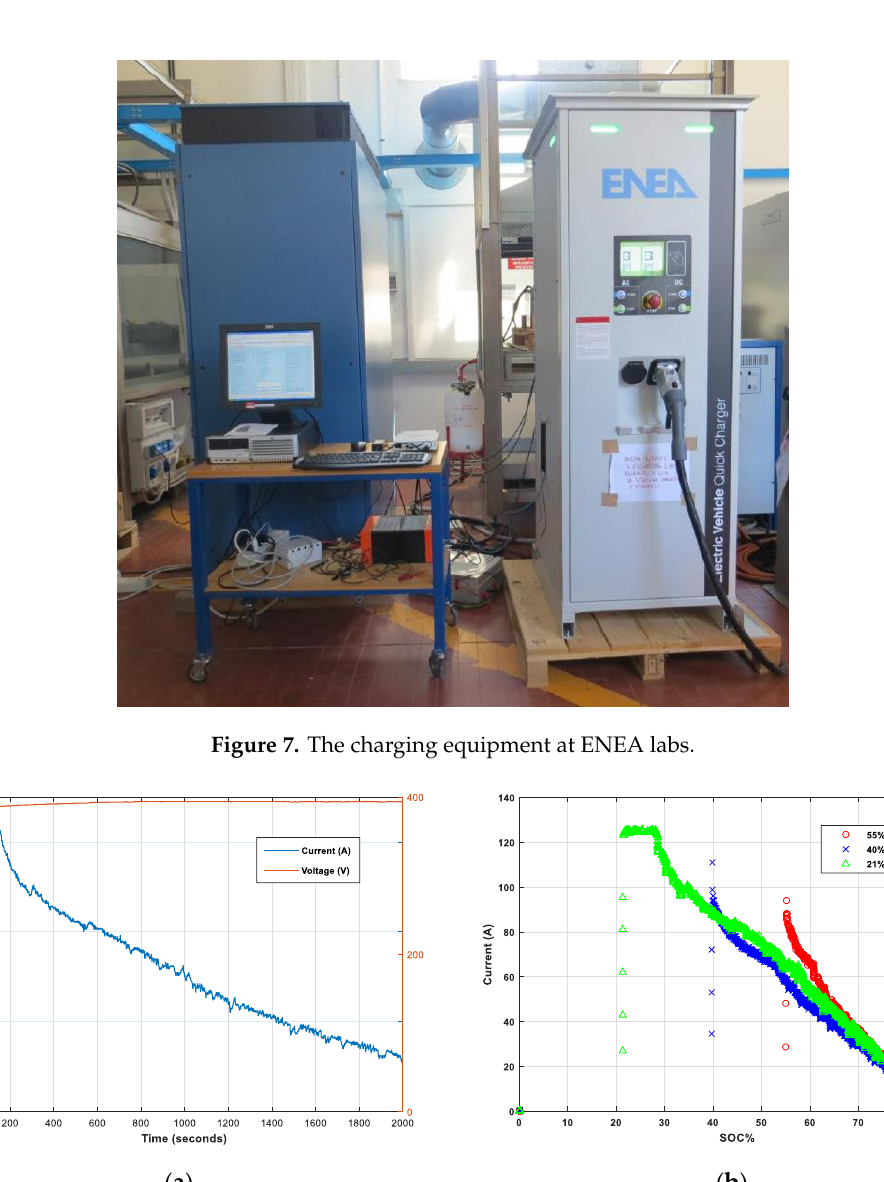
Figure 8. ( a ) Battery voltage (red) and absorbed current (blue) during a fast charge, for initial state of charge (SOC) of 21%; ( b ) charge current profiles at three different initial SOC.